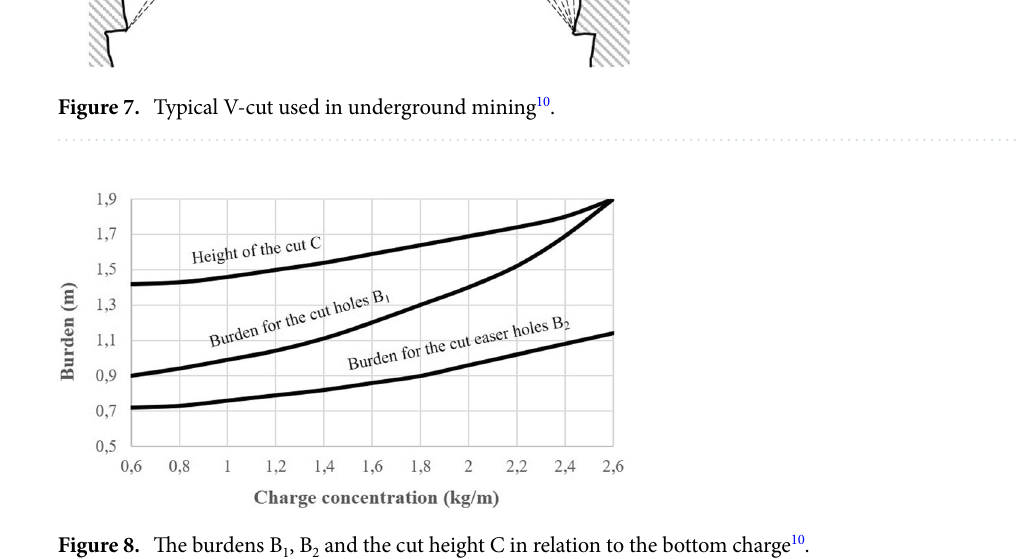
Figure 8. The burdens B 1 , B 2 and the cut height C in relation to the bottom charge 10